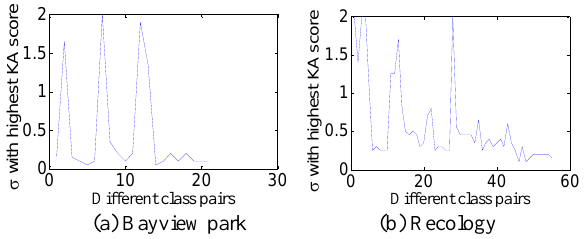
Figure 2.  with highest KA scores of different class